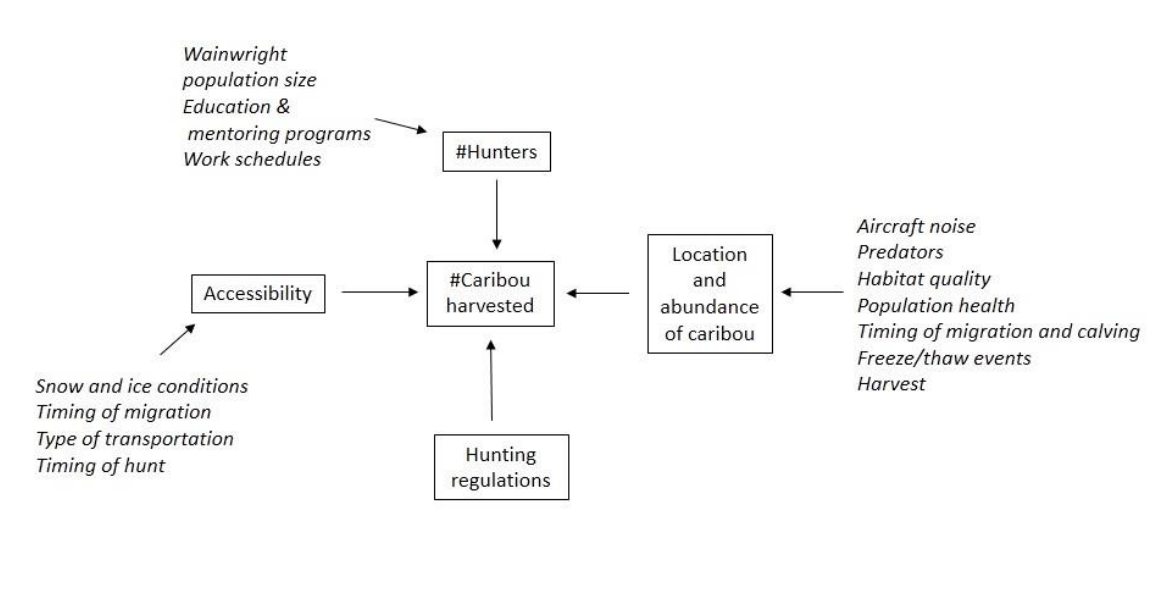
Figure A1.1. Model of the caribou subsistence system in Wainwright, Alaska